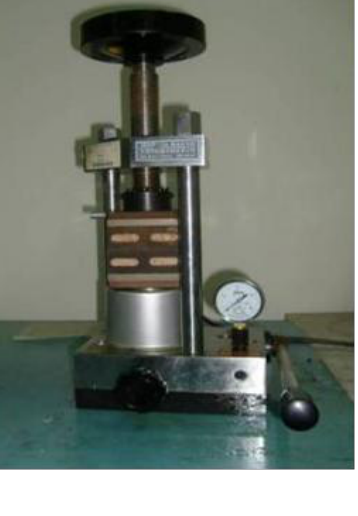
Figure 2. Hot embossing and thermal bonding